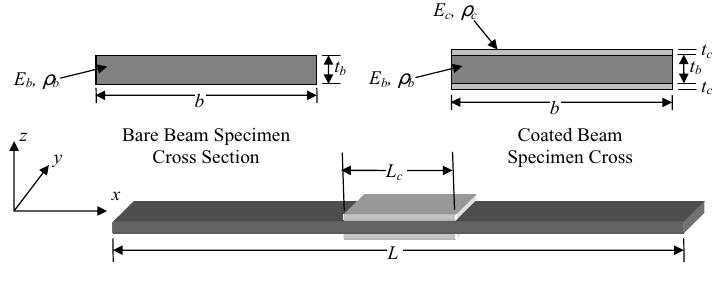
Fig. 4. Beam specimens.